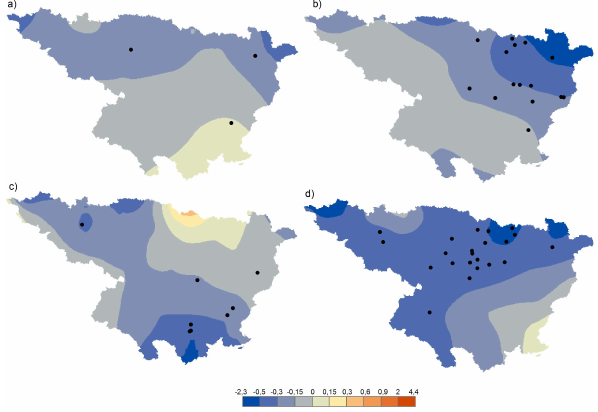
Fig. 8. Per decade change in the number of daily rainfall erosivity events corresponding to the fifth (Q5) quintile at the seasonal scale for the period 1955–2006: (a) DJF, (b) MAM, (c) JJA, (d) SON. Black circles indicate significant trends at the α = 0 . 05 confidence level.